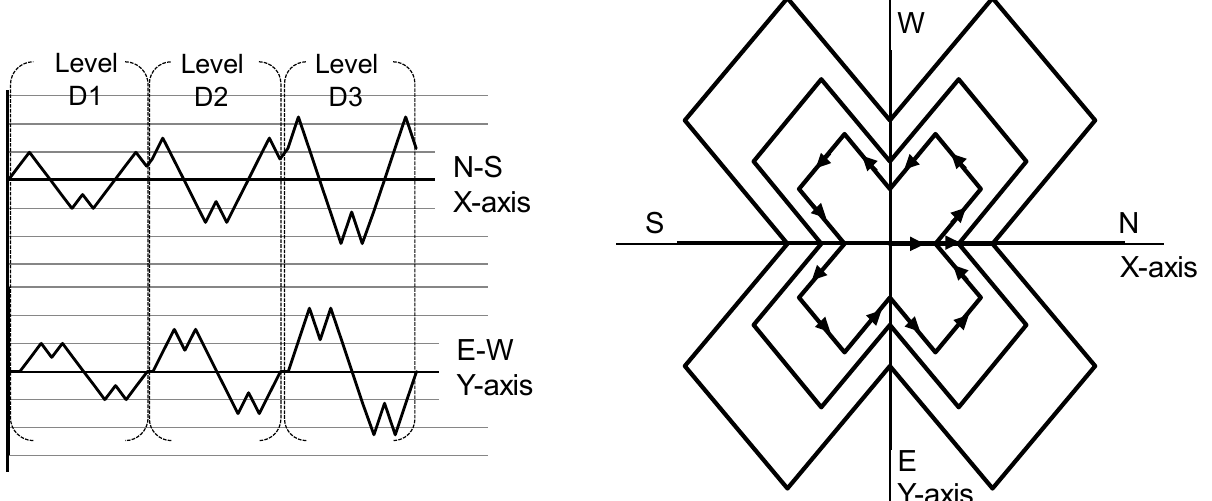
Figure 15. Proposal for a rational bidirectional loading protocol.